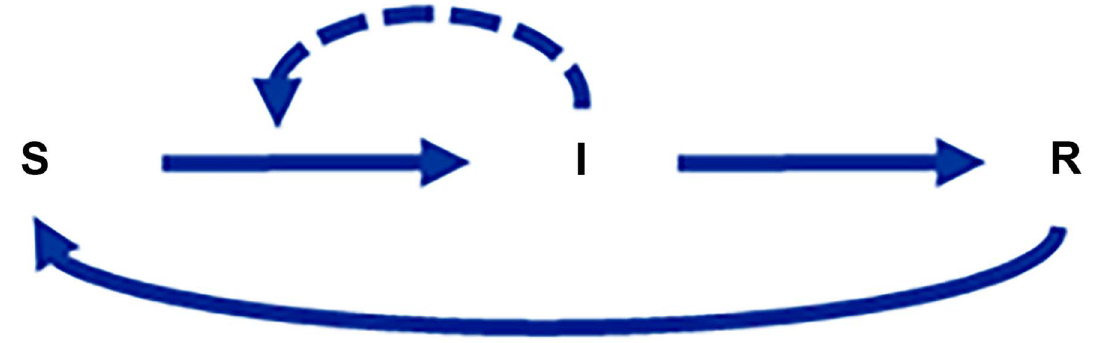
Fig. 2. Typical prototype for a model describing the spread of an infectious disease. S, I, and R describe pools of susceptible, infected, and recovered individuals. Susceptible individuals only become sick as the result of contact with an infected person.